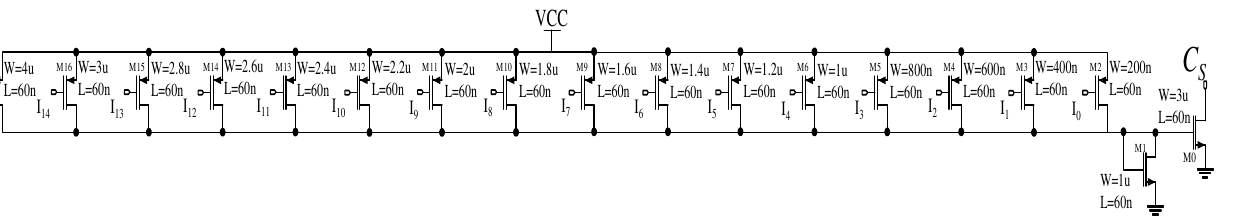
Figure 3. ( a ) Schematic of delay cell, ( b ) Block diagram of the ring oscillator [7].